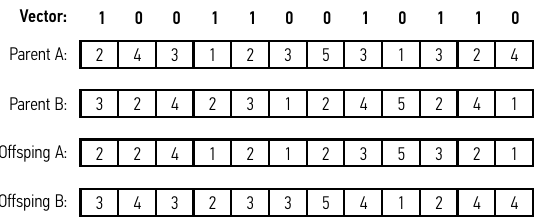
Fig. 6. Crossover operator of upper-level genetic